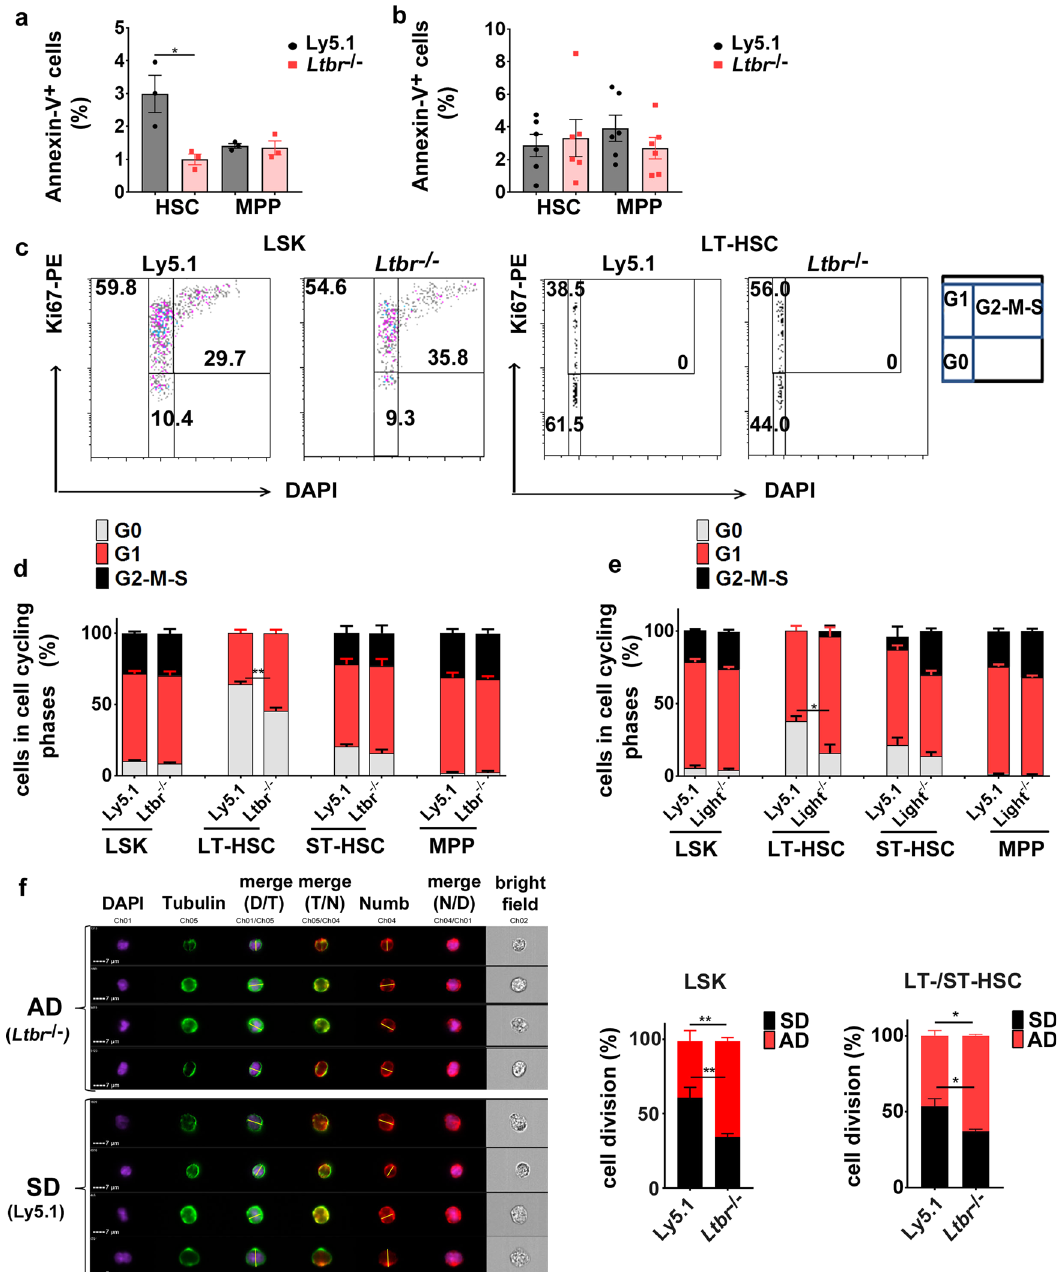
Fig. 4 Ltbr de fi ciency induces proliferation and differentiation of HSCs. a , b Percentages of Annexin-V + HSCs and MPPs 6 ( a ) and 12 ( b ) weeks after 1st transplantation, black: Ly5.1, red: Ltbr − / − . One out of two independent experiments is shown, for a : n = 3, for b : n = 6 mice c Representative dot plot of the cell cycle analysis as determined by Ki67 and DAPI staining of Ly5.1 and Ltbr − / − BM LSKs and LT-HSCs 12 weeks after primary transplantation. Numbers in plots are shown as percentages of cells in each cell cycle phase, G0 in gray, G1 in red, and G2 – M – S in black. d Frequency of Ly5.1 and Ltbr − / − LSKs, LT- HSCs, ST-HSCs and total MPPs in different cell cycle phases 12 weeks post transplantation. Data are representative for two independent experiments, n = 3. e Frequency of Ly5.1 and Light − / − LSKs, LT-HSCs, ST-HSCs, and total MPPs (CD48 + ) in different cell cycle status 12 weeks post transplantation. LSKs were isolated from two to three chimeric mice and pooled for the analysis. Pooled data from two independent experiments are shown. f Representative picture of Numb distribution in dividing Ly5.1 and Ltbr − / − FACS-puri fi ed LT/ST-HSCs 10 – 12 weeks after transplantation. DAPI in violet, α -tubulin in green, and Numb in red. Plane cell division (yellow line) was assigned based on α -tubulin and the cleavage furrow. Left: Quanti fi cation of Ly5.1 (92 cells from n = 3, pooled for the analysis) and Ltbr − / − LSKs (135 cells from n = 4, pooled for the analysis) in SD (black) or AD (red). Right: Quanti fi cation of Ly5.1 (45 cells from n = 9, pooled for analysis) and Ltbr − / − LT/ST-HSCs (28 cells from n = 9, pooled for analysis) in symmetric cell division (SD) or asymmetric cell division (AD). Cells were analyzed by ImageStreamX MkII. Nuclei were stained with DAPI. Data are shown as mean ± SEM. Statistics: * P < 0.05, ** P < 0.01 (two-tailed t test), a : p = 0.028; f (AD, SD right panel): p = 0.033.